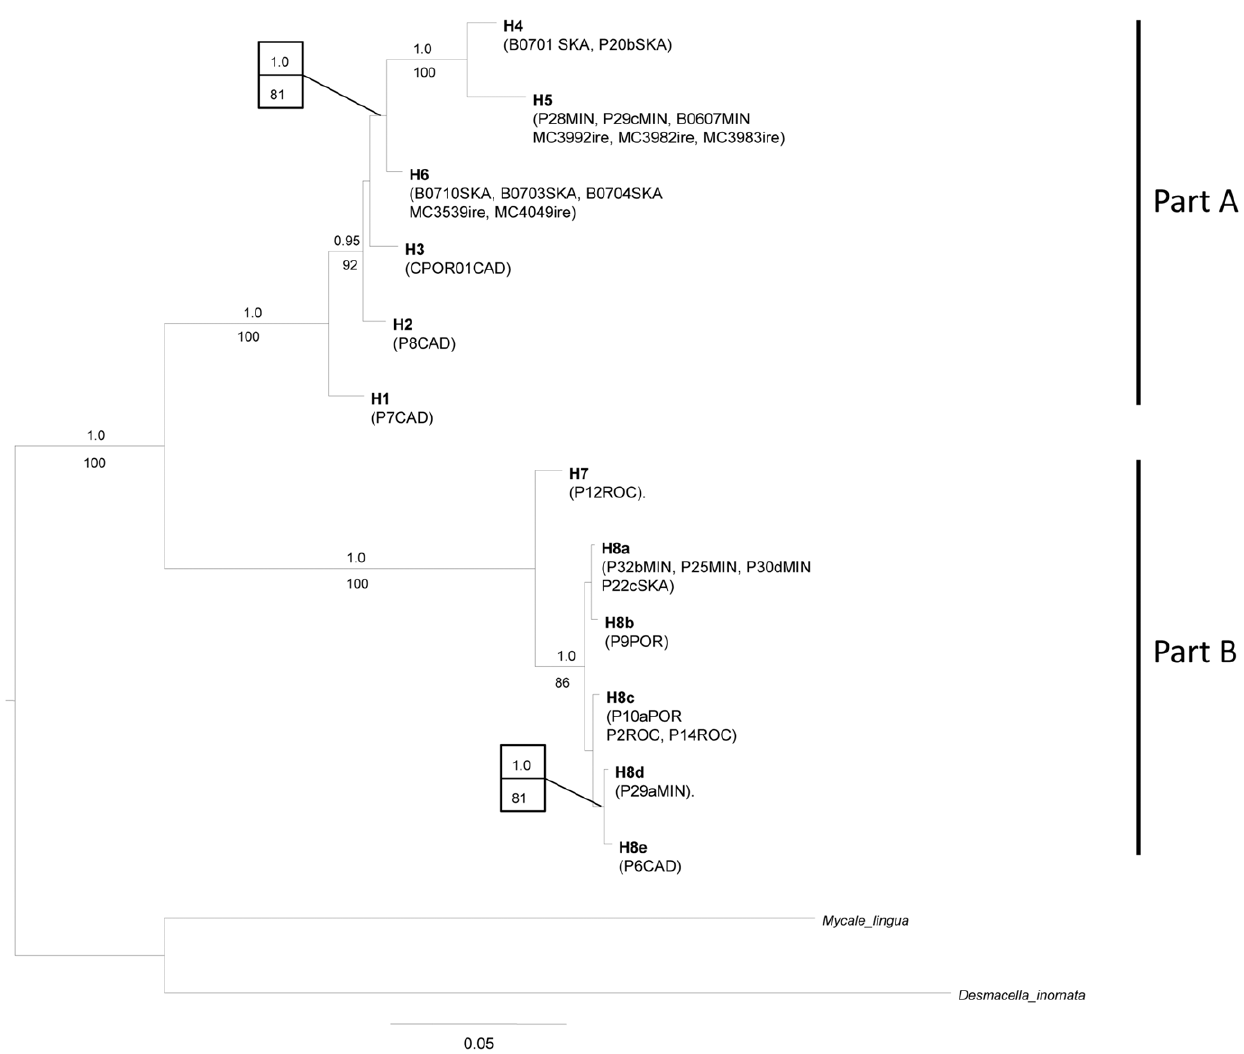
Figure 2. Bayesian majority-rule consensus tree of the mtDNA COI M1M6 and I3M11 partitions. Bayesian posterior probabilities (when . 0.95) and the ML bootstrap values (when . 70) are indicated above and below branches, respectively. For information on the specimens (listed in parenthesis) see Table S1.